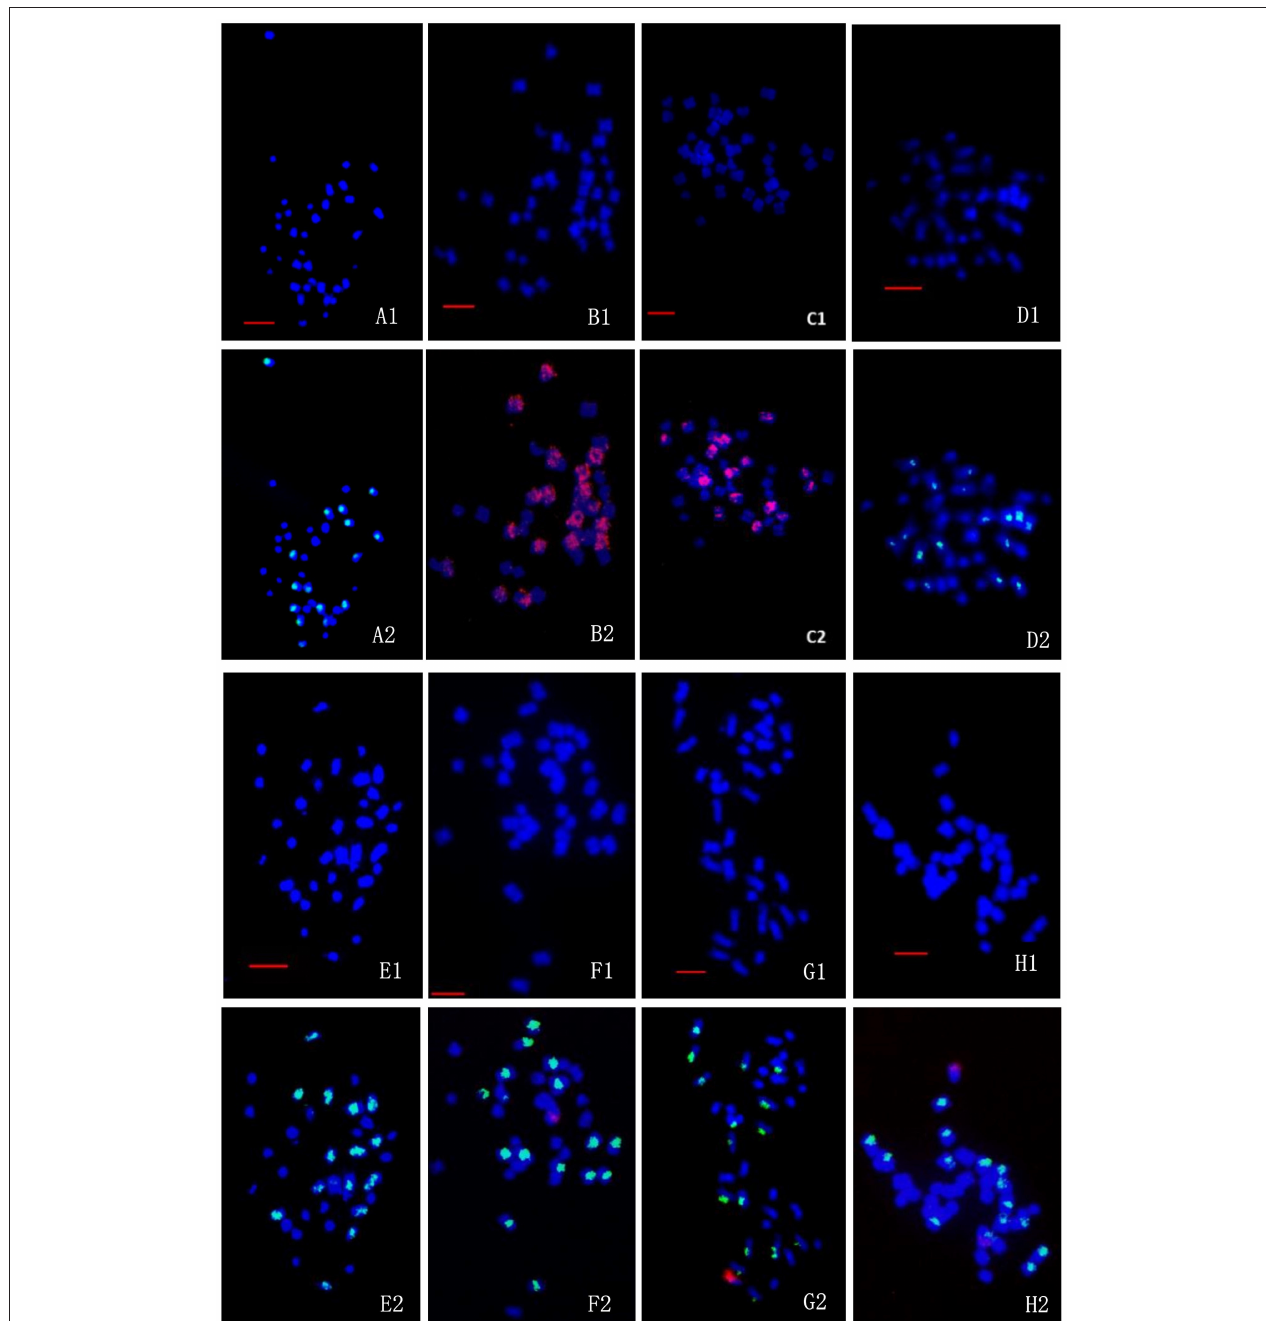
FIGURE 6 | FISH/BAC-FISH analyses of the chromosome constitutions of the somatic cells of wild Brassica juncea , transgenic oilseed rape, and the fourth-generation progenies of BC1. (A1–H1) are the DAPI (blue) images for all chromosome, and (A2–H2) are merged images of the DAPI (blue), B chromosome probe (green), and C chromosome probe (red). (A1-A2): wild B. juncea : 20A + 16B. (B1-B2): transgenic oilseed rape with glyphosate-tolerant gene: 20A + 18C. (C1-C2): transgenic oilseed rape with glufosinate-tolerant gene: 20A + 18C. (D1-D2): the cells of BC1mF4R with 36 chromosomes: 20A + 16B. (E1-E2): the cells of BC1pF4R with 36 chromosomes: 20A + 16B. (F1-F2): the cells of BC1mF4L with 37 chromosomes: 20A + 16B + 1C. (G1-G2): the cells of BC1pF4L with 37 chromosomes: 20A + 16B + 1C. (H1-H2): the cells of BC1pF4L with 37 chromosomes: 20A + 15B + 2C. Green fluorescent signals from probe of B. nigra , red fluorescent signals from C genome-specific BAC BoB014O06. BC1mF4R and BC1pF4R indicate the glyphosate-tolerant fourth-generation progenies of the first backcross generation (BC1) obtained from wild Brassica juncea × F1R or F1R × wild B. juncea , respectively. B C1mF4L and BC1pF4L indicate the glufosinate-tolerant fourth-generation progenies of the first backcross generation (BC1) obtained from wild Brassica juncea × F1L or F1L × wild B. juncea , respectively. F1R and F1L indicate glyphosate- or glufosinate-tolerant F1 hybrids obtained from wild B. juncea × glyphosate- or glufosinate-tolerant transgenic oilseed rape. Progenitors in front of the × are always the maternal plants, and the progenitors after the × are always the paternal plants. All bars: 5 µ m.